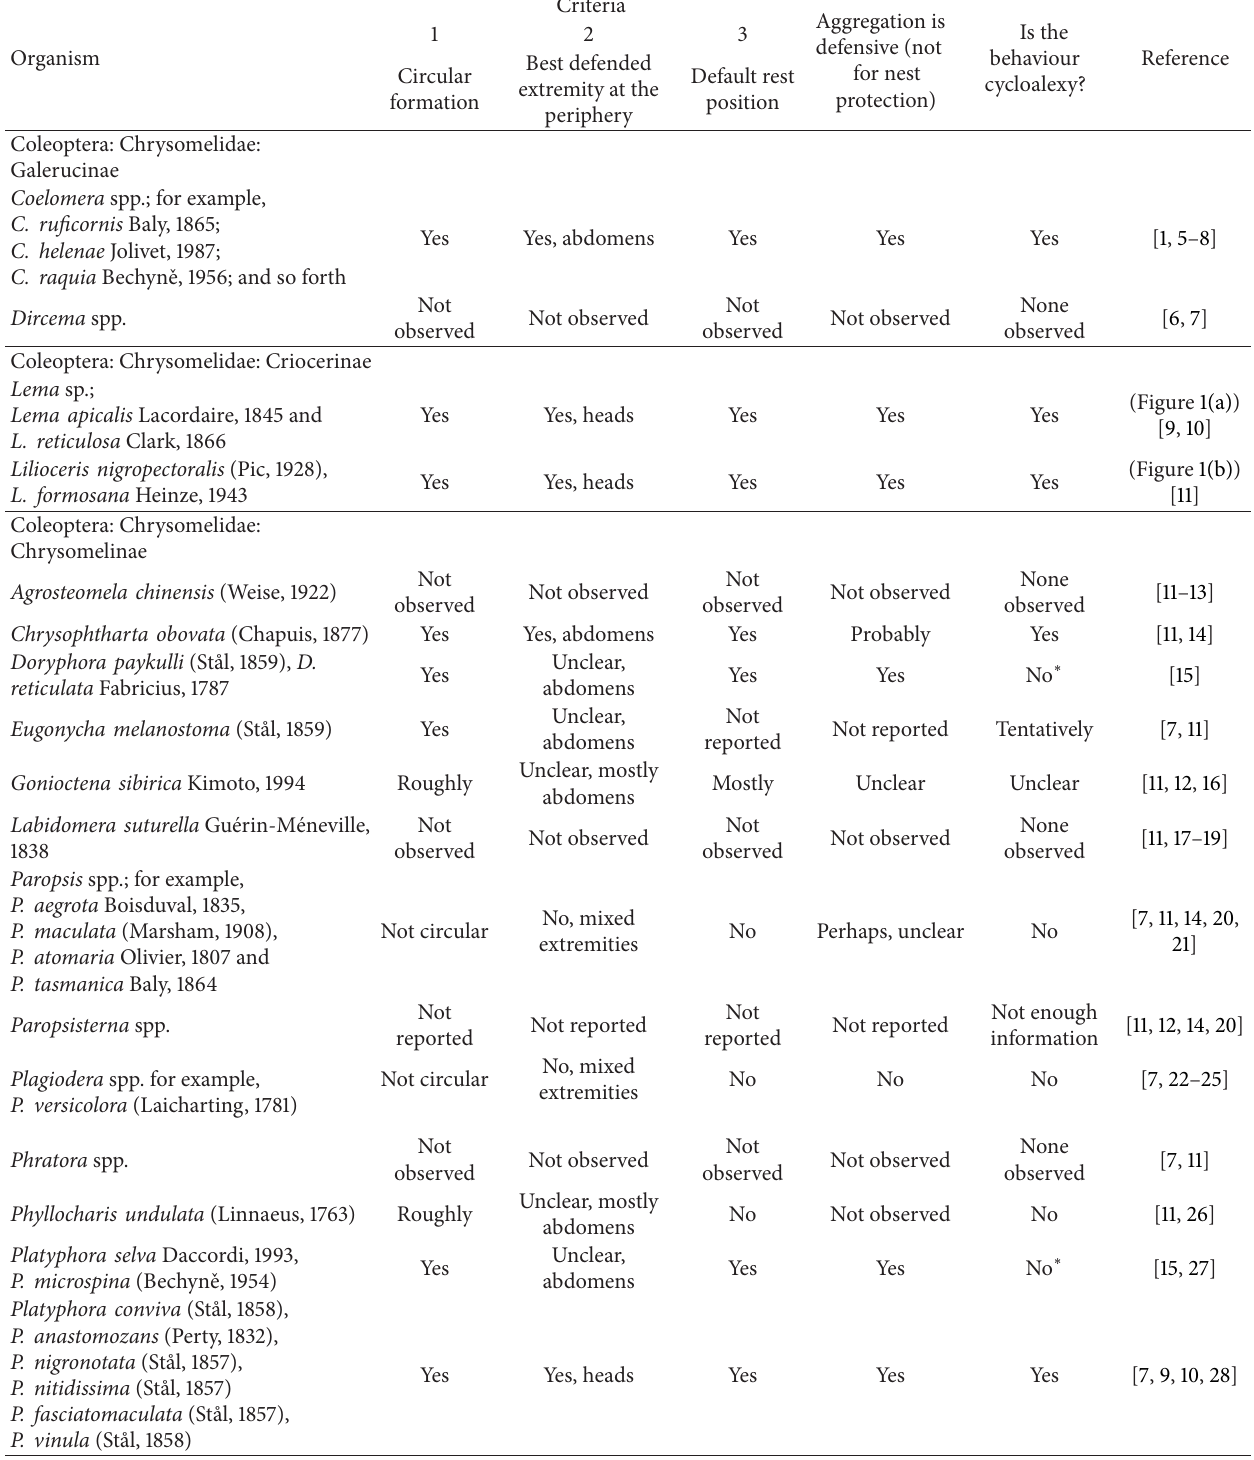
Table 1: Reported cases of cycloalexy and how they fit within the revised definition.